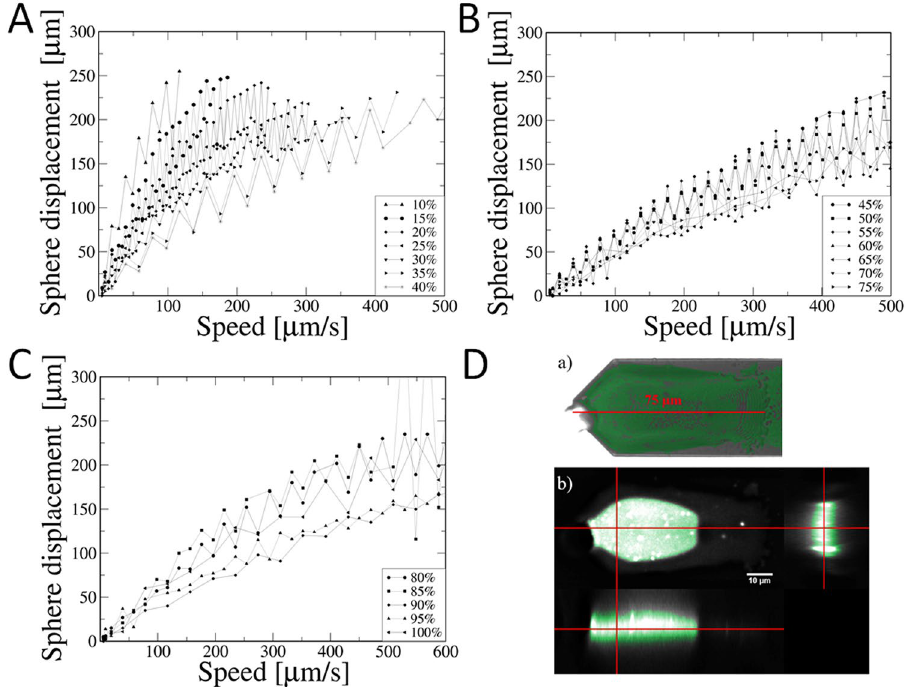
Figure 2. Panels A–C: Calibration curves for determination of the trap stiffness presented as a dependence of the laser beam speed on the sphere displacement. The laser beam power was in the range of: ( A ) 10–40%, ( B ) 45–75%, and ( C ) 80–100%. Panel D: The reconstruction of the epoxy glue distribution on the cantilever: (a) fluorescence microscopy image, and (b) three-dimensional (3D) reconstruction. 3D reconstructions were assembled with a fluorescence microscopy to visualize the distribution of adhesive layers on the cantilever surface. The adhesive layer was marked with a green color. Images were captured on the confocal setup shown in Fig. 1C and then deconvolved using the DeconvolutionLab software 40–42